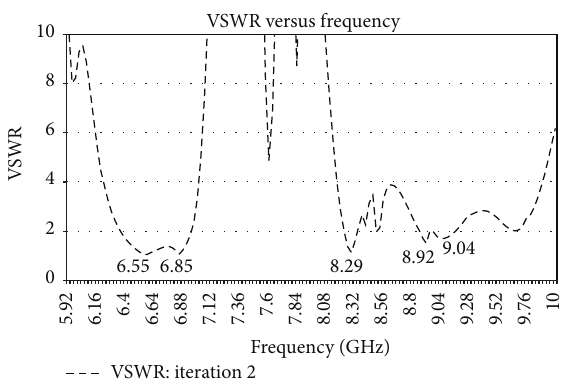
Figure 8: VSWR for iteration 2.